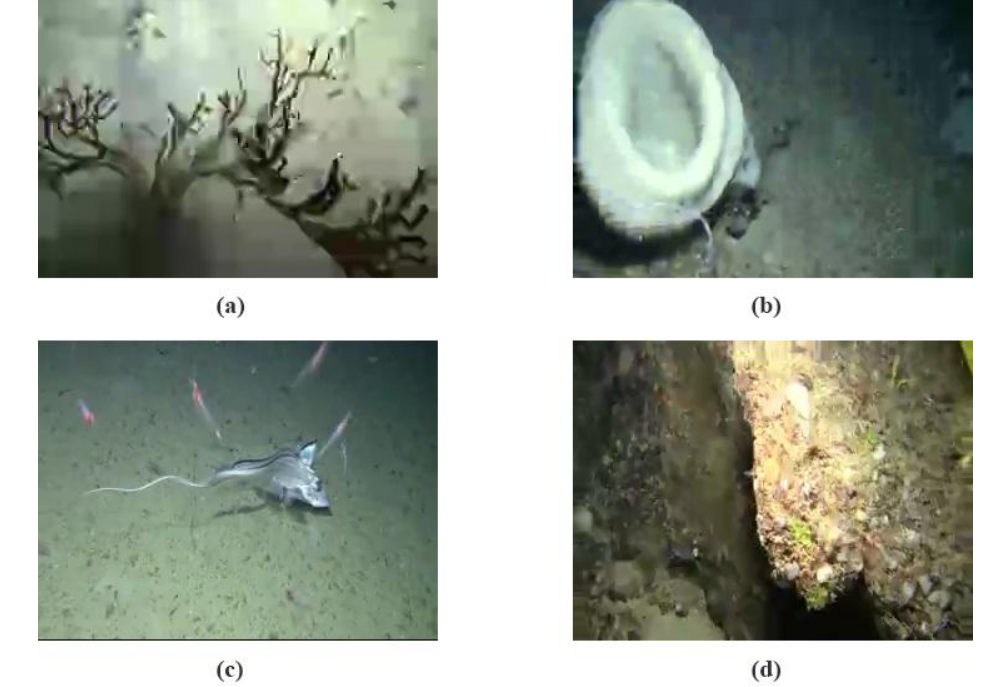
Figure 4. Sample frames (QVGA, RGB color). ( a ) 8 kbps–5 fps—high variation content; ( b ) 14 kbps–5 fps—high variation content; ( c ) 20 kbps–5 fps—low variation content, ( d ) 14 kbps–1 fps—high variation content.